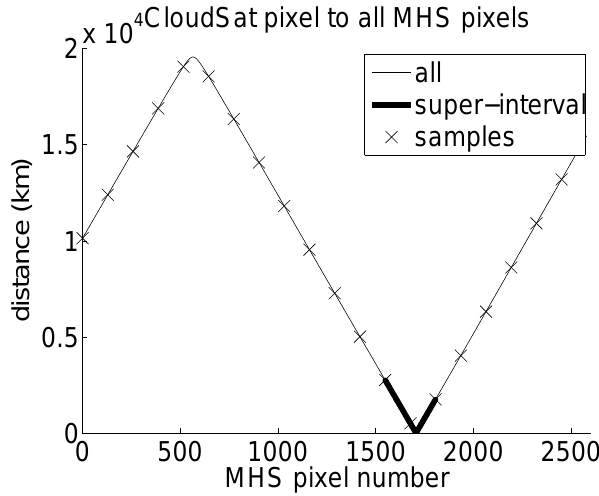
Fig. 2. Illustration of collocation principle. For this example, we consider the CloudSat granule starting 6 January 2007 at 01:10UTC and the MHS granule starting at the same date at 00:26UTC. The figure shows the distance from pixel number 11166 from the Cloud- Sat granule to all MHS pixels at a viewing angle of − 0 . 56 ◦ . The crosses show twenty equally spaced samples and the thick line shows the super-interval to be searched for collocations. Refer to the text for further explanation.